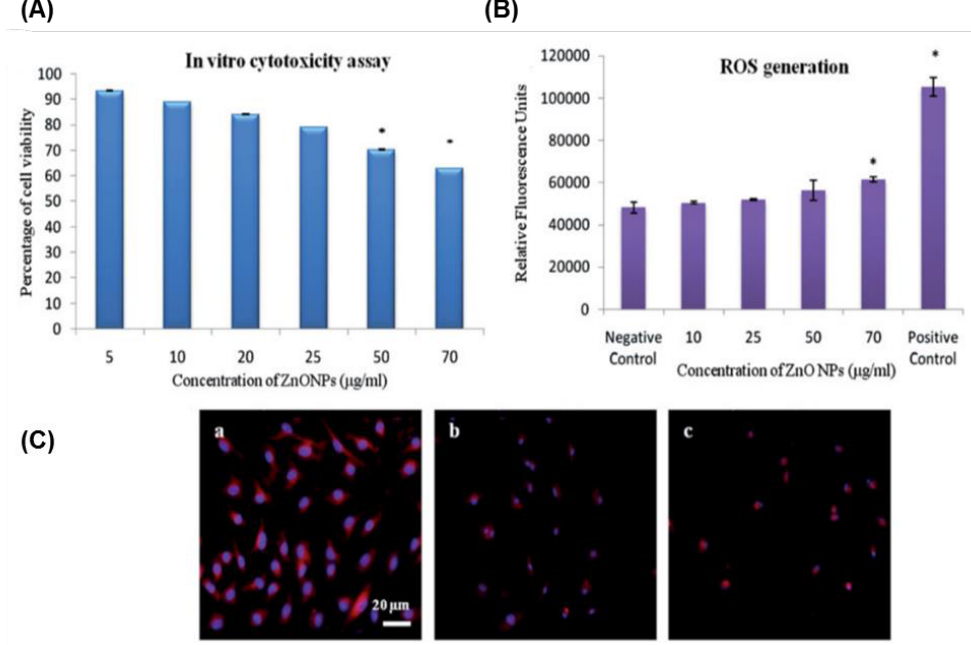
Figure 5. ZnO NP-induced toxicity in mBM-MSCs in ROS-mediated mechanism. ( A ) MTT assay data showing dose-dependent cytotoxicity in MSC (* p < 0.05). ( B ) The quantitative estimation of ROS generation in ZnO NP-exposed MSCs represented in fluorescence units (* p < 0.05). ( C ) ZnO NP-treated MSCs show abnormal actin filaments. Reproduced from [185] with permission from Taylor & Francis.